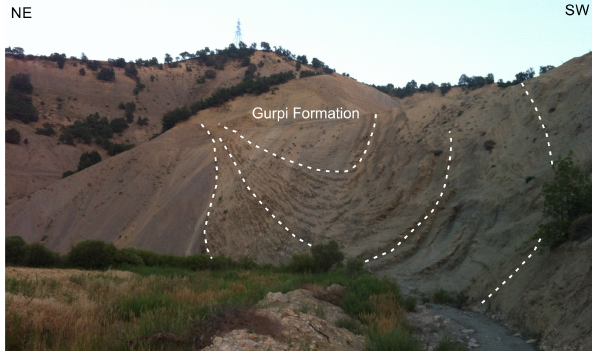
Figure 5. Growth syncline in the limestones of the Gurpi Forma- tion (Campanian–Maastrichtian in age) in the High Zagros zone (see Fig. 2 for the